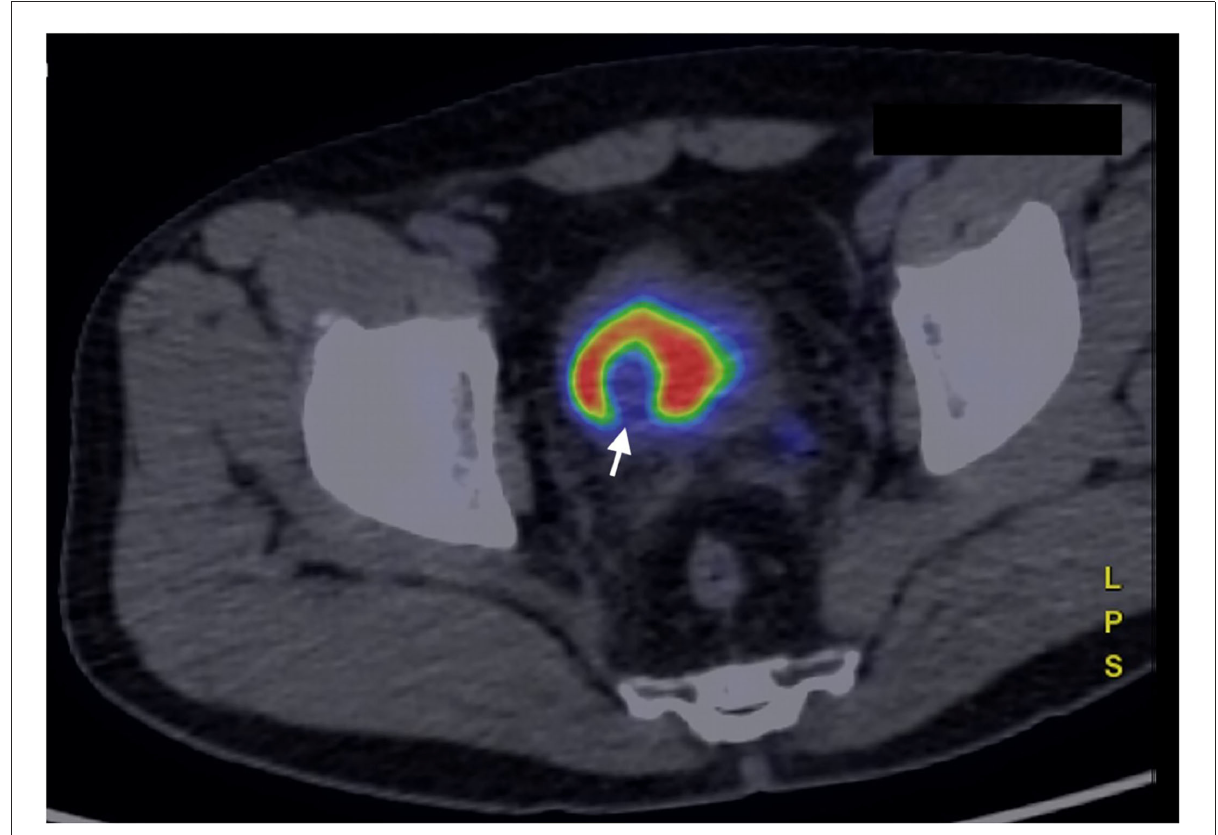
FIGURE4 FDG PET/CT (image fusion technique) acquired in a late phase, 60min after administration of the 18 FDG. The bladder lesion is characterized by complete washout of the 18 FDG, that collects in the urine, within the bladder (white